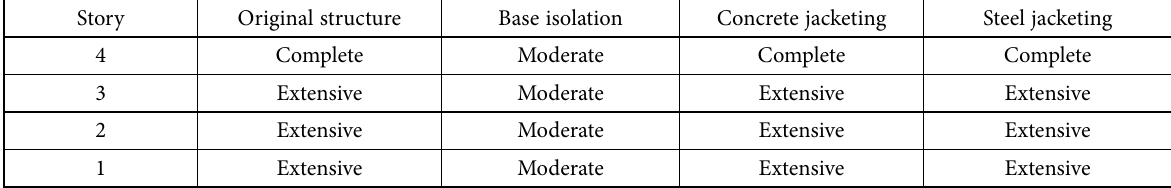
Table 3. Non-structural damage levels for acceleration-sensitive components